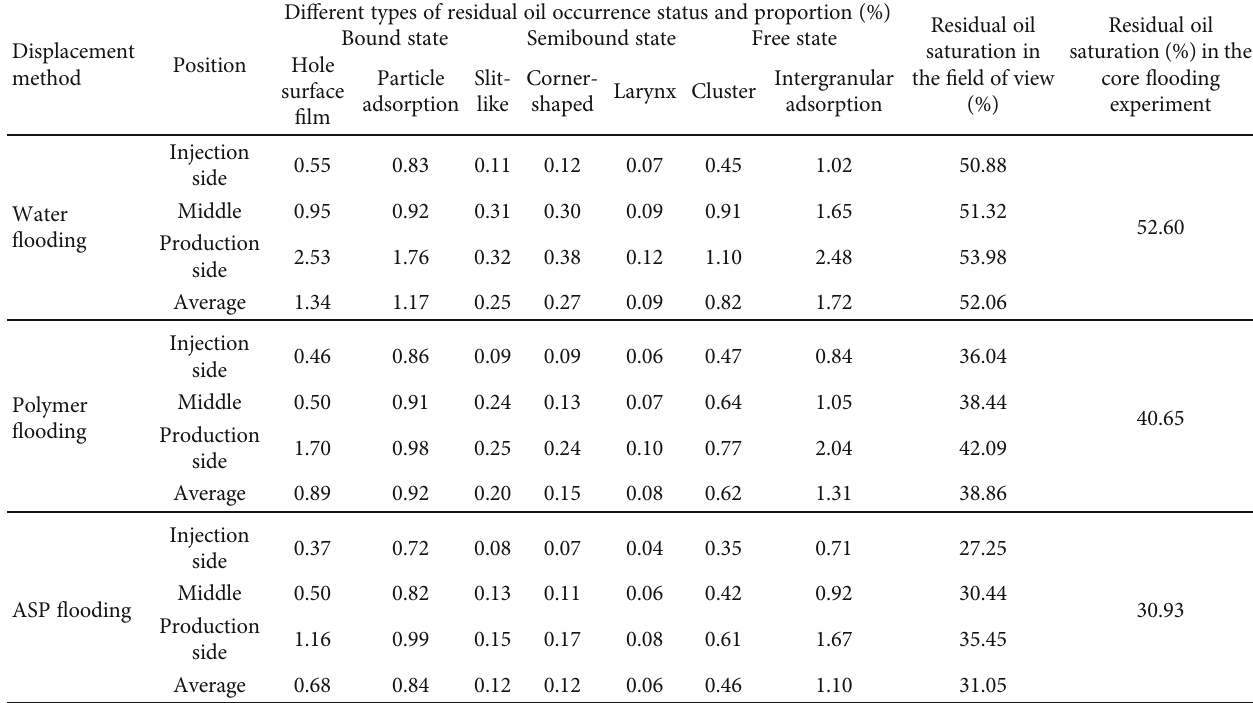
Table 4: Absolute proportion of microscopic residual oil (each oil content in the table is the average of 20 analysis results).